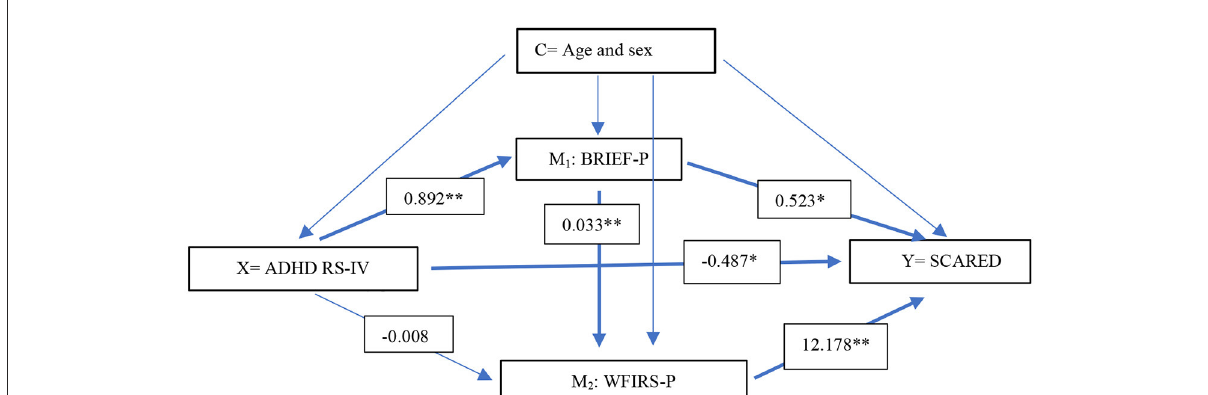
FIGURE2 Regression coefficients for the associations between parent-report measures of ADHD RS-IV and SCARED (self-report) with BRIEF and WFIRS as possible mediators. Age and sex were considered confounders ( n = 90). X predictor, Y dependent variable, C confounder, M 1 mediator 1, M 2